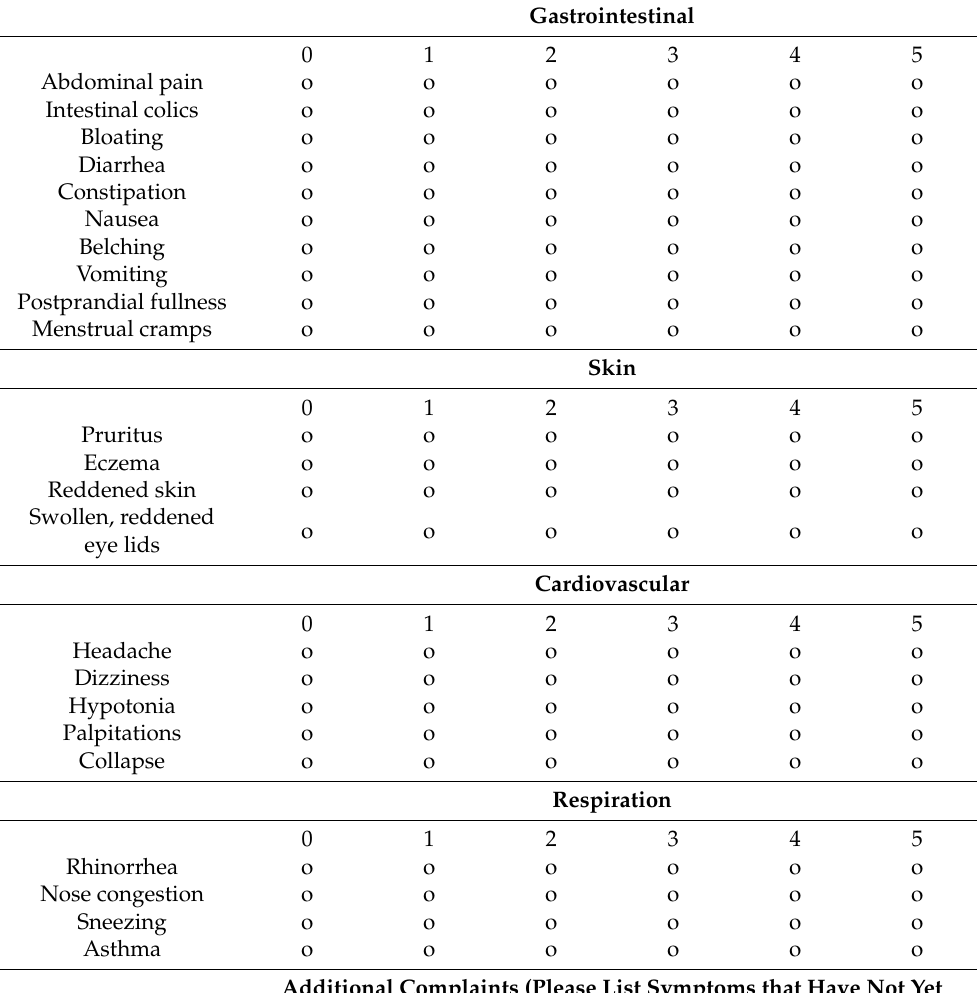
Table 1. Example of a standardized questionnaire for evaluation of patients with suspected histamine intolerance